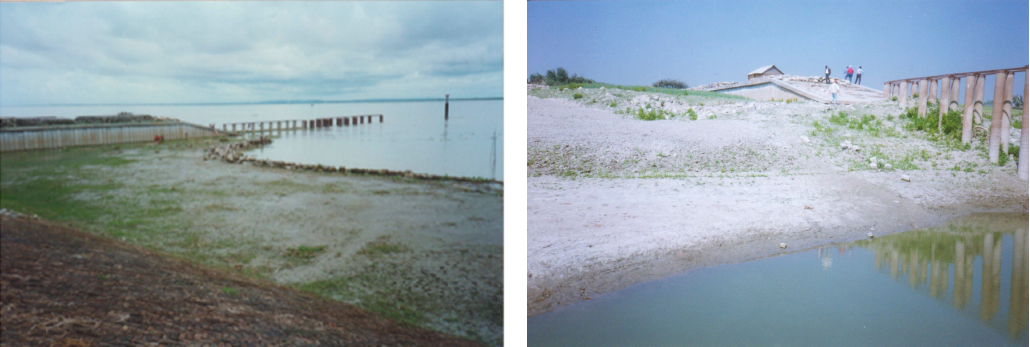
Figure 11. Damaged groyne G-2 with lost piles during high water and scour hole downstream of the transition shank and pile row probably caused by floating debris changing the gradual transition in a sudden transition during low water (photographs taken by the author).